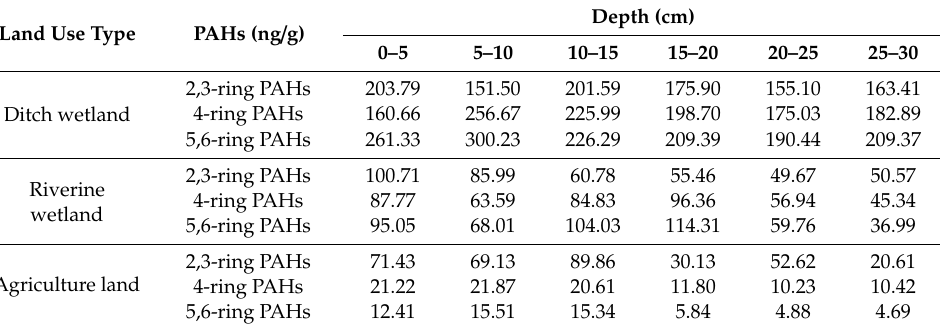
Table 4. Composition of PAHs in di ff erent depths of three land use